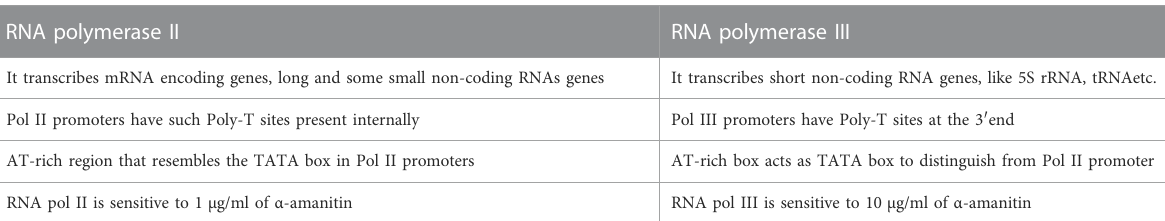
TABLE 1 Similarities and differences between RNA Pol II and RNA Pol III